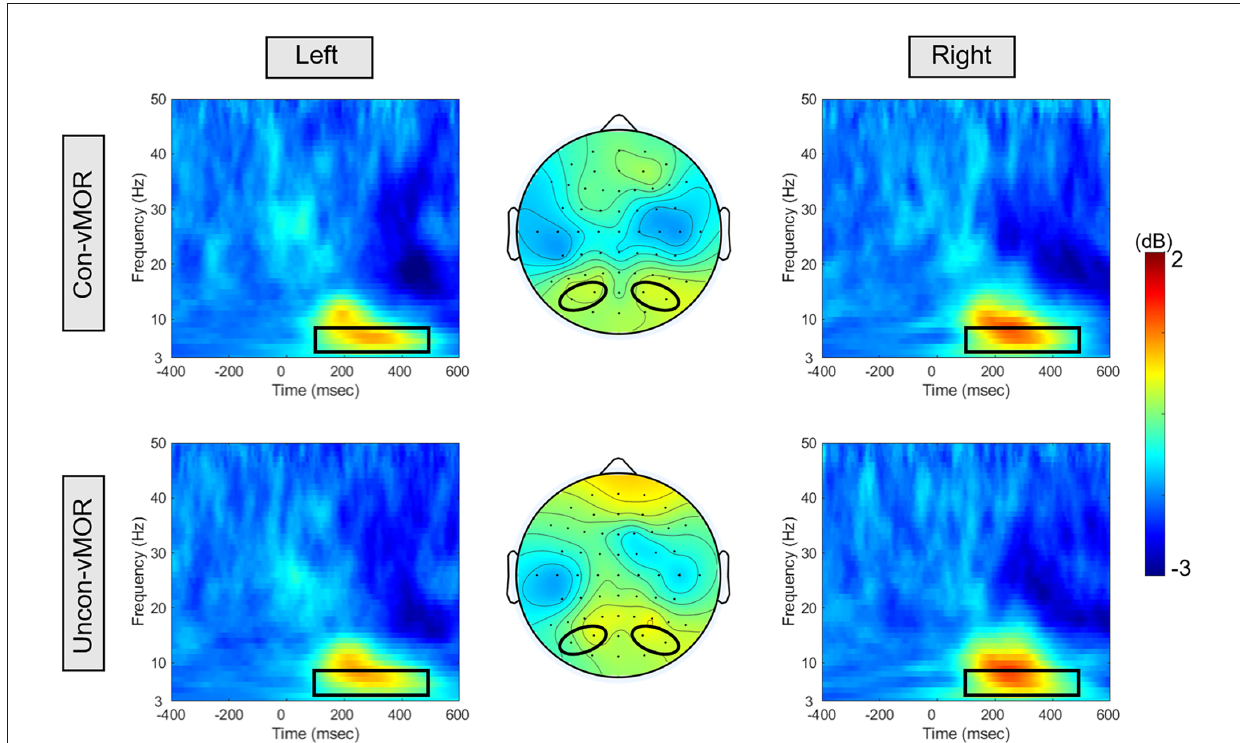
FIGURE3 ERSPs and their isocontour map for each condition. The panels show the ERSPs in the Con-vMOR condition in the left area (PO3, PO7; upper left panel), the Con-vMOR condition in the right area (PO4, PO8; upper right panel), the Uncon-vMOR condition in the left area (lower left panel), the Uncon-vMOR condition in the right area (lower right panel), and their isocontour maps (the upper map is in the Con-vMOR condition, and the lower map is in the Uncon-vMOR condition). The black box in the ERSPs indicates a time-frequency window of 100–500 ms and 4–8 Hz. Con-vMOR, conscious-visual mismatch oscillatory response; Uncon-vMOR, unconscious-visual mismatch oscillatory